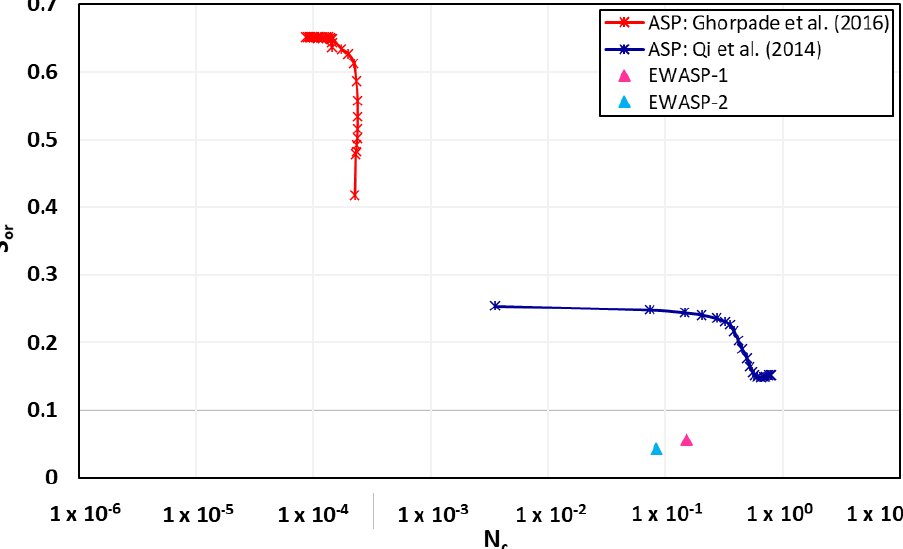
Figure 6. Comparison of capillary desaturation tendency of hybrid EWASP flooding with conven- tional ASP flooding.